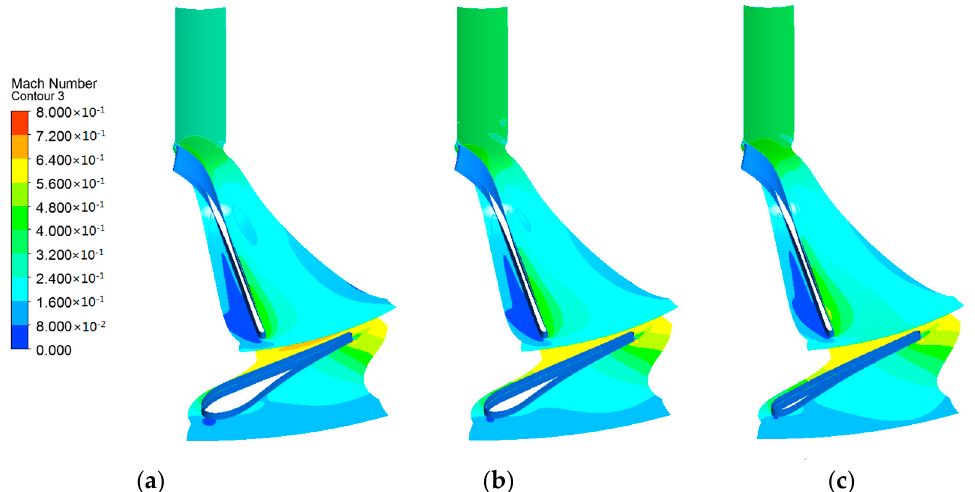
Figure 10. Machnumbercontoursatthemid-spanofimpellerandnozzle: ( a )LED=10mm; ( b )LED=7mm; Figure 10. Mach number contours at the mid-span of impeller and nozzle: ( a ) LED = 10 mm; ( b ) LED ( c ) LED = 4 = 7 mm; ( c ) LED = 4 mm.